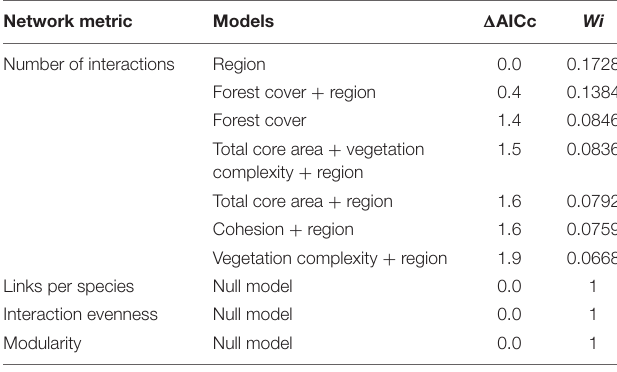
TABLE 1 | Model selection parameters based on Akaike’s Information Criterion (AIC), used to explain the relationship between dependent variables (number of interactions, links per species, interaction evenness, and modularity) and environmental predictors (forest cover, total core area, edge density, cohesion, fruit availability, and vegetation complexity) recorded in 19 forest sites located in the Brazilian Atlantic Forest. Network metric